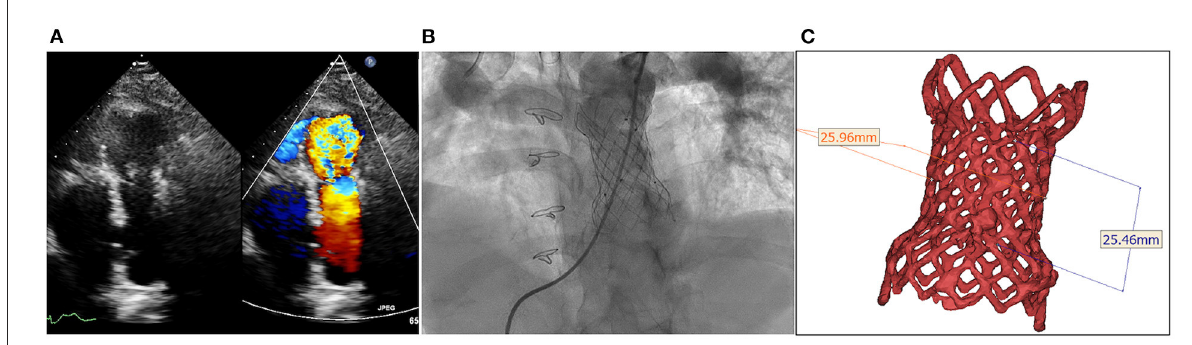
FIGURE1 Degenerated bioprosthesis with complete frame. (A) Transthoracic echocardiography shows severe pulmonary regurgitation; (B) Angiography reveals severe pulmonary insufficiency; (C) The annular size calculated on computed